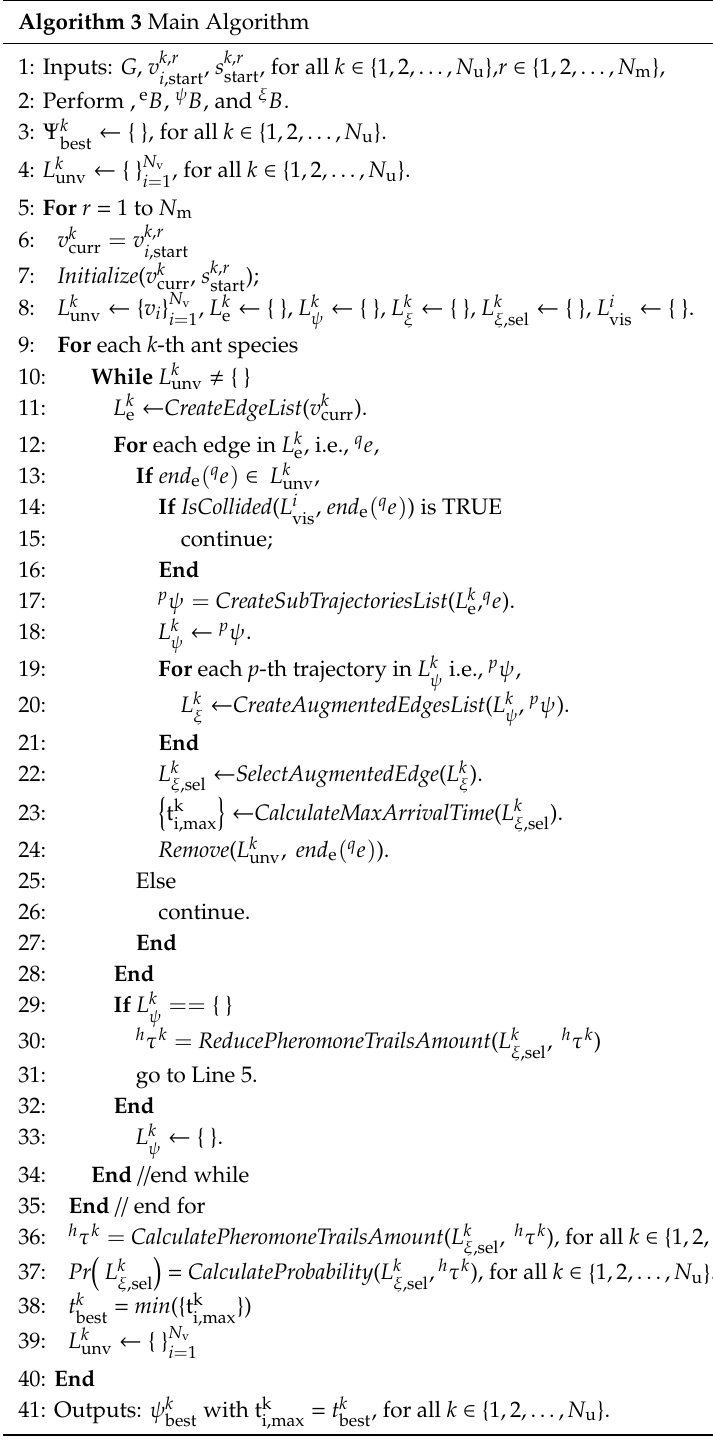
Algorithm 3 Main